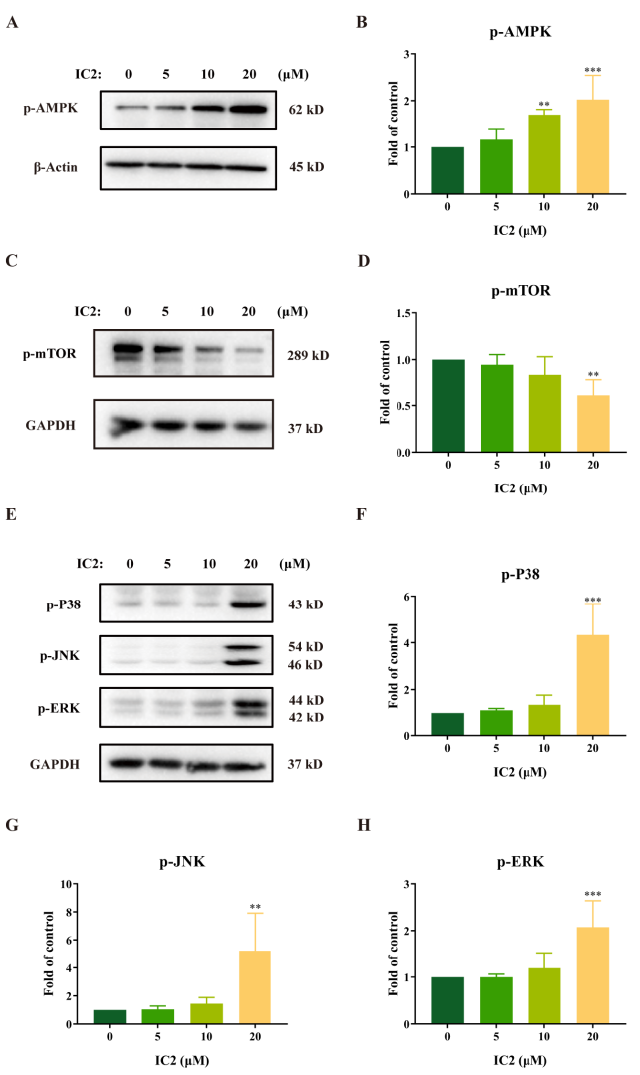
Figure 3. IC2-induced autophagy is correlated with the AMPK and MAPK signaling pathways. After IC2 treatment for 24 h, the expression of ( A ) p-AMPK (Thr172), ( C ) p-mTOR (Ser2448), ( E ) p-P38 (Thr180/Tyr182), p-JNK (Thr183/Tyr185) and p-ERK (Thr202/Tyr204) was determined in MCF-7 cells by Western blot. Quantification of the protein expression levels of ( B ) p-AMPK (Thr172), ( D ) p-mTOR (Ser2448), ( F ) p-P38 (Thr180/Tyr182), ( G ) p-JNK (Thr183/Tyr185) and ( H ) p-ERK (Thr202/Tyr204) in MCF-7 cells. All blots are representative of at least three repeats. * p < 0.05, ** p < 0.01 and *** p < 0.001 compared with the control group.